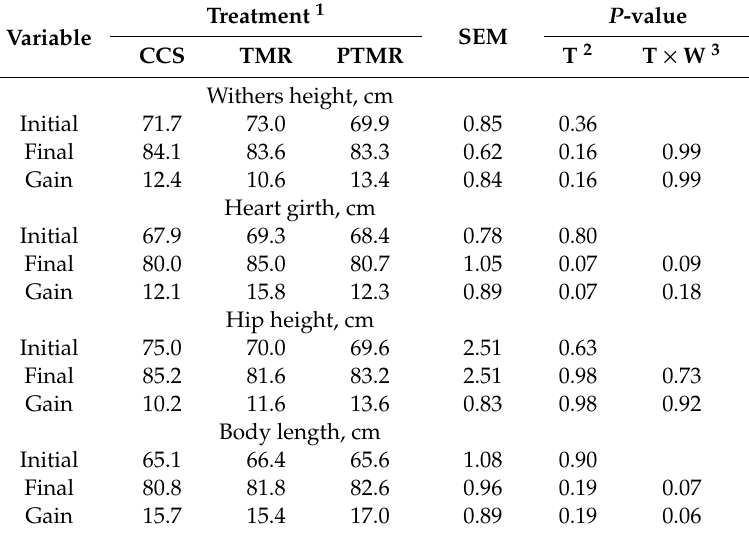
Table 4. E ff ect of feeding calf starter and oat hay as TMR or in pelleted form on preweaning body measurement of crossbred calves.